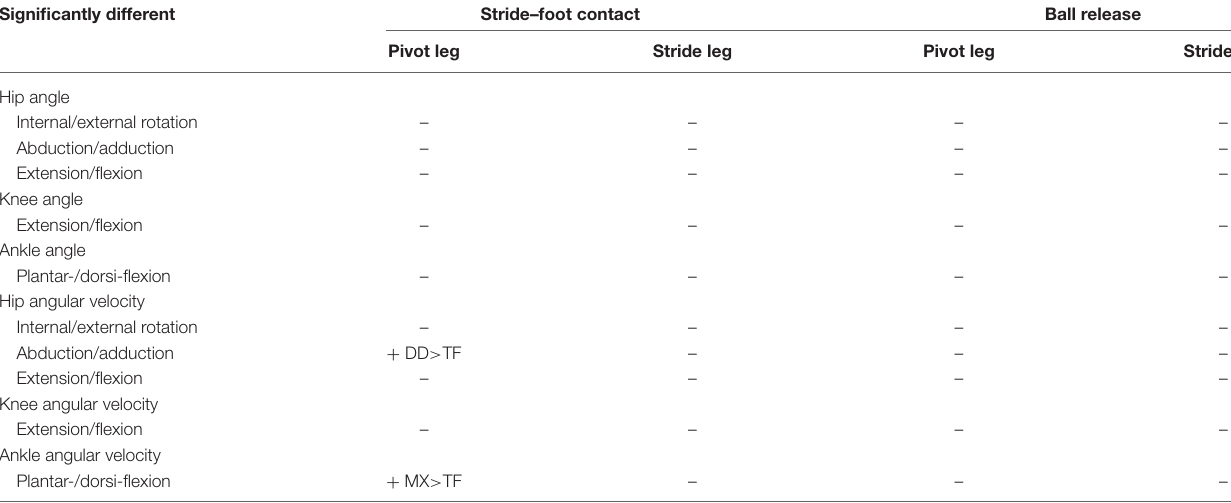
TABLE 3 | Statistical summary of joint angle and joint angular velocity at selected events.